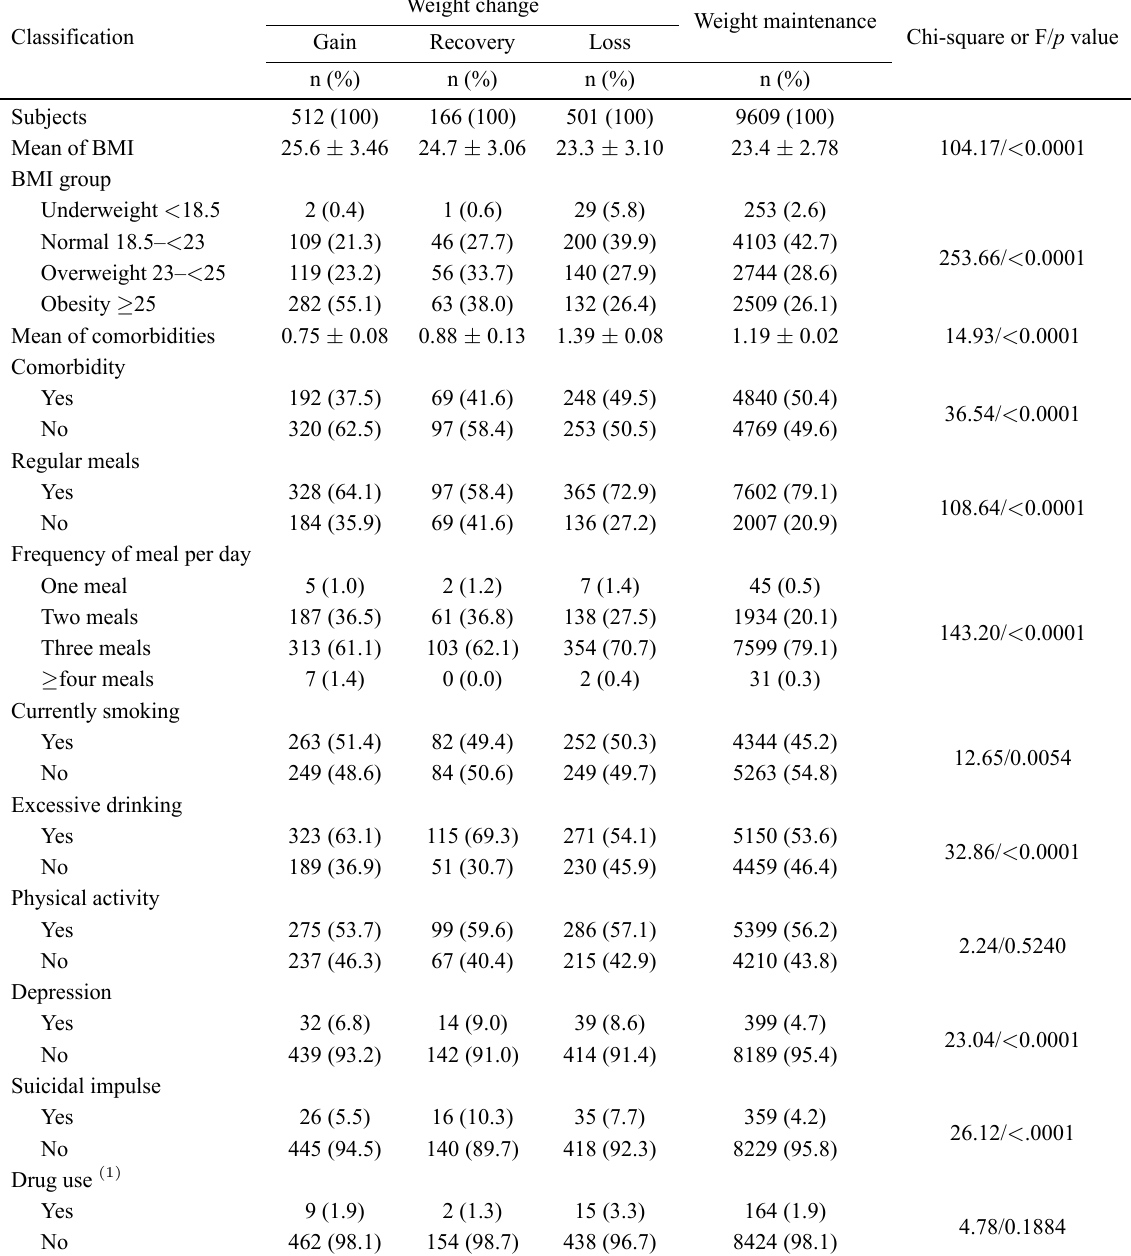
Table 3. Physical, health behavioral, and psychological characteristics by males’ weight change and weight maintenance. Weight Classification